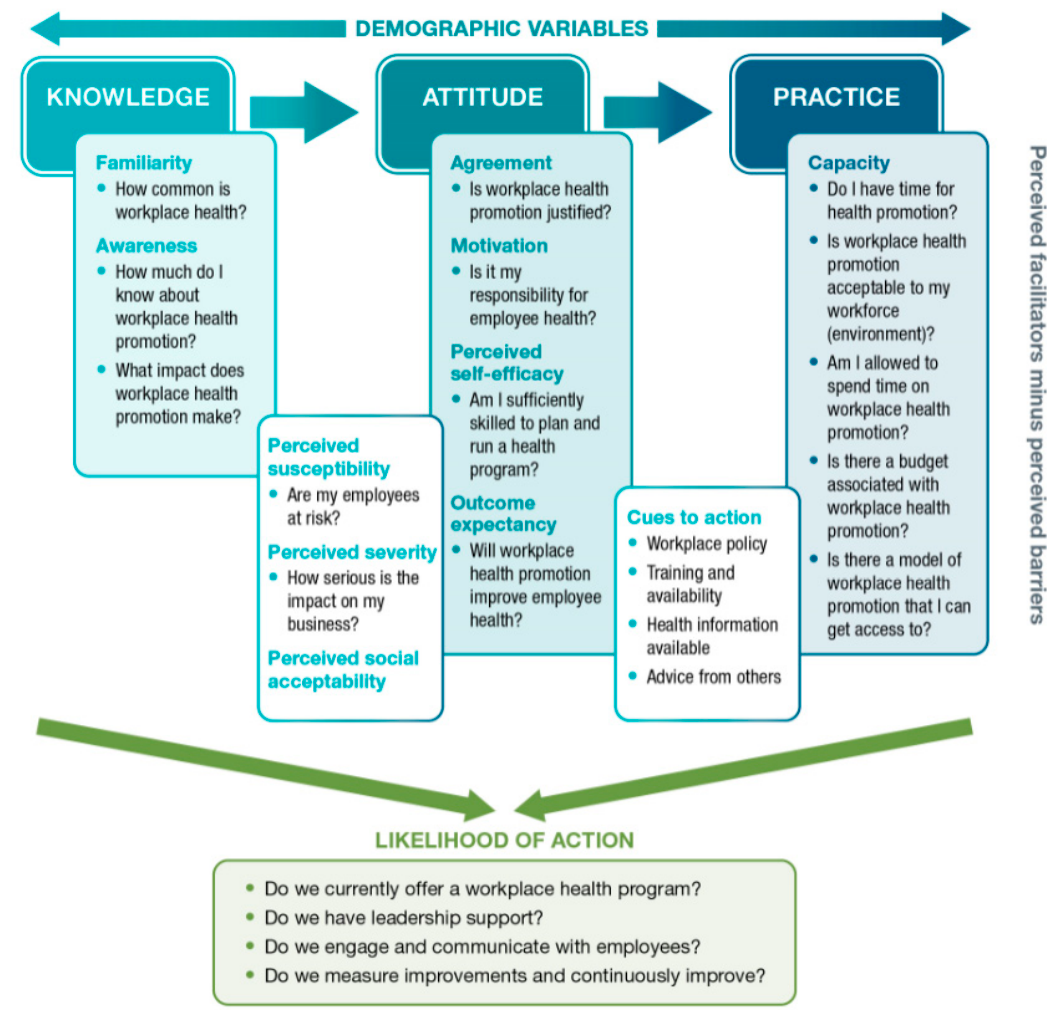
Figure 1. Conceptual Framework of Knowledge, Attitude and Practices as Determinants for Workplace Health Promotion Likelihood of Action. Adapted from [26].